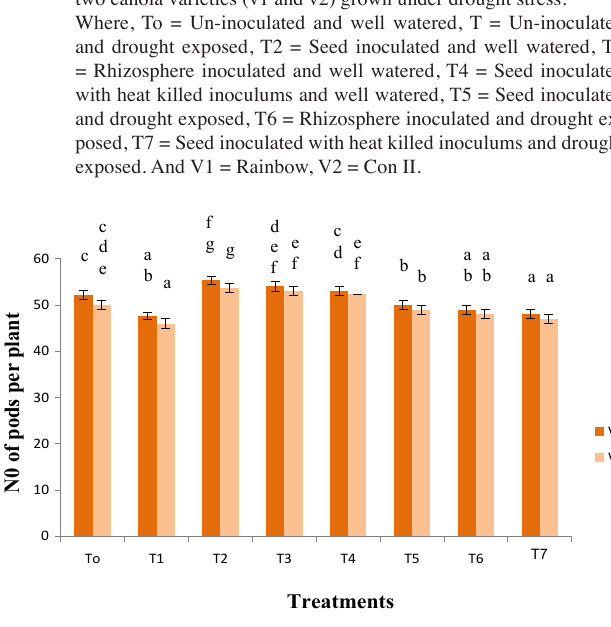
Fig. 5B: Effect of Azospirillum inoculation on number of pods per plant of two canola varieties (v1 and v2) grown under drought stress. Where, To = Un-inoculated and well watered, T = Un-inoculated and drought exposed, T2 = Seed inoculated and well watered, T3 = Rhizosphere inoculated and well watered, T4 = Seed inoculated with heat killed inoculums and well watered, T5 = Seed inoculated and drought exposed, T6 = Rhizosphere inoculated and drought ex- posed, T7 = Seed inoculated with heat killed inoculums and drought exposed. And V1 = Rainbow, V2 = Con